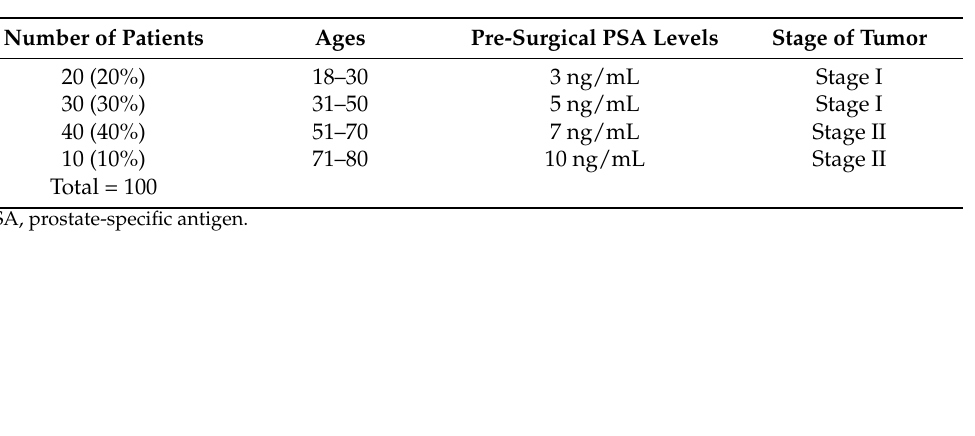
Table 6. Distribution of age comparison, PSA and stages of tumor in percentage (100%) in group